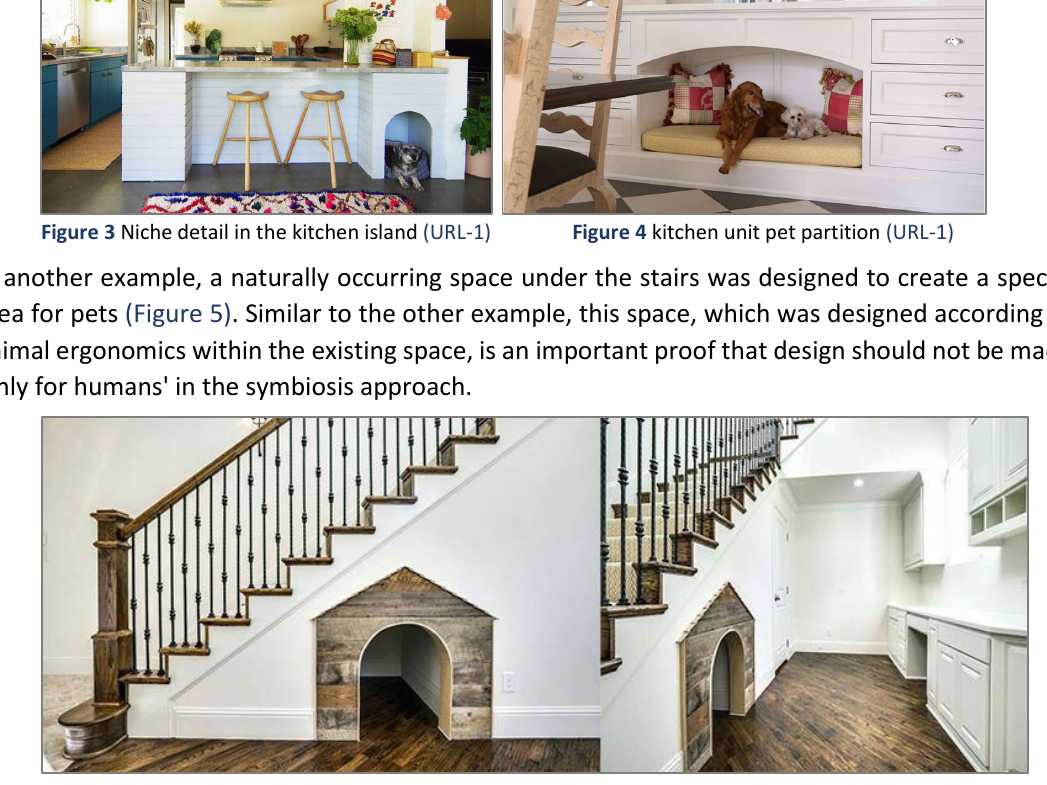
Figure 5 Under-stair pet area (URL-1)